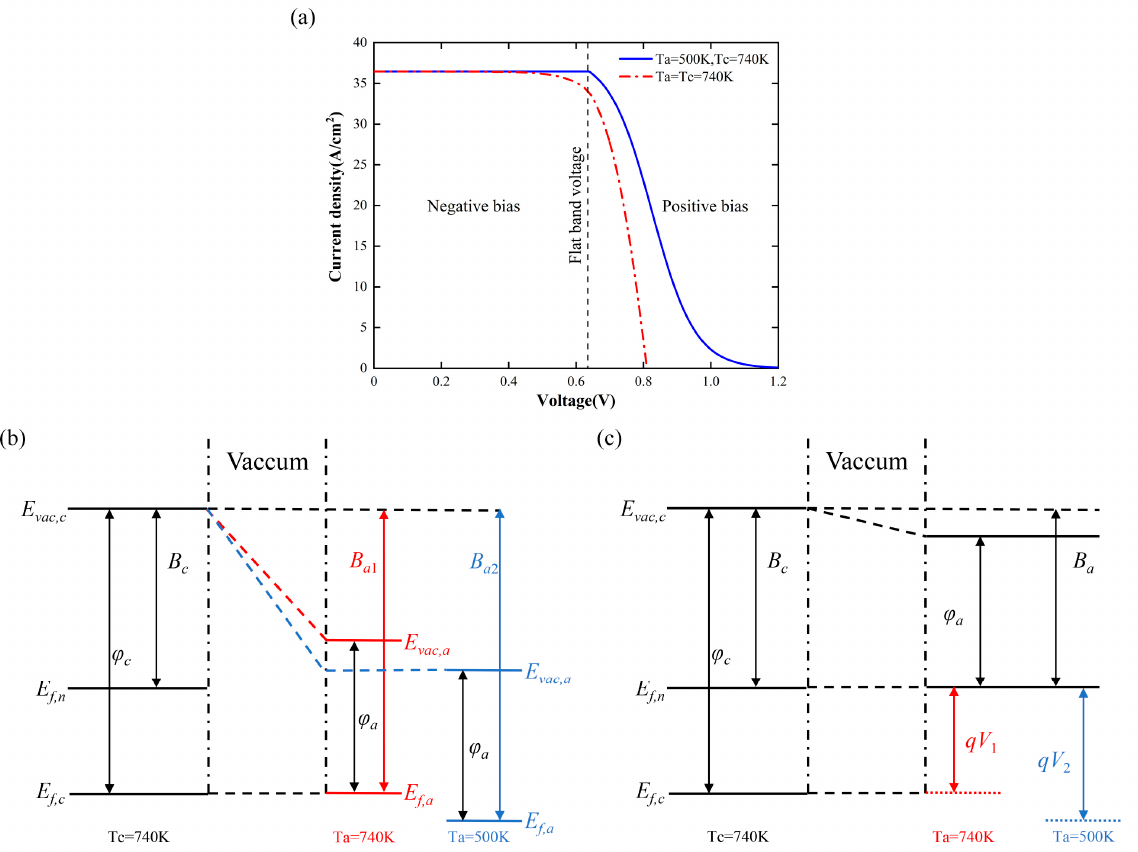
Figure 6. ( a ) At different anode temperature, T c = 740 K, and χ = 0.6 eV, the relationship between the current and the output voltage. The schematic bandgap diagram at ( b ) zero bias and ( c ) positive bias. The blue and red lines indicate nonisothermal and isothermal conditions, respectively.